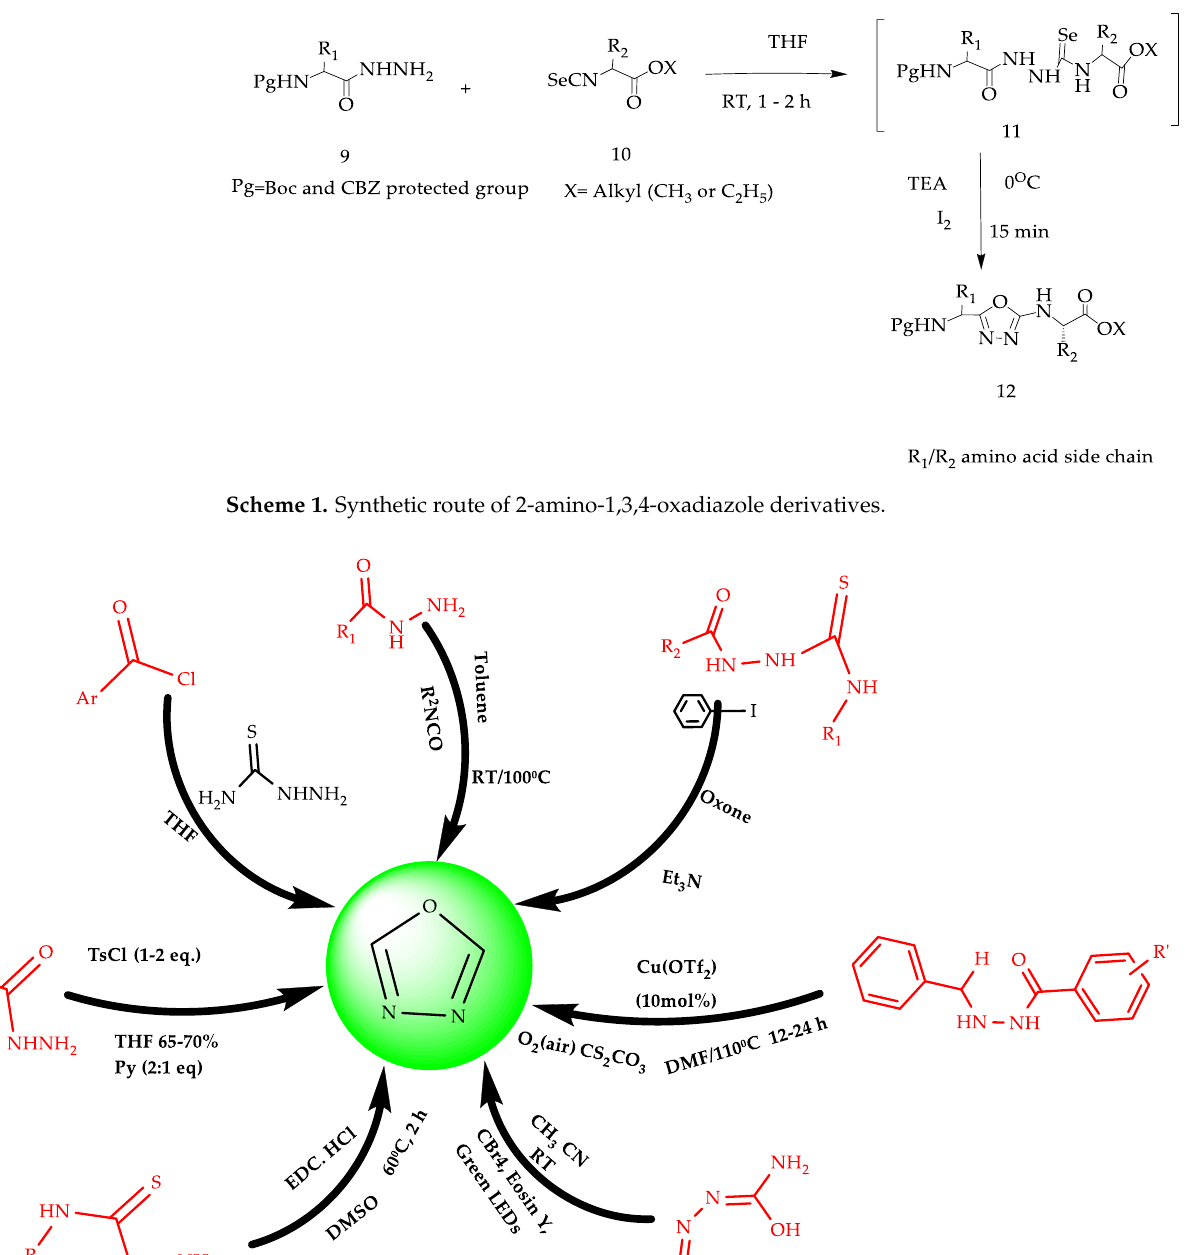
Figure 6. Various synthetic approaches for 1,3,4-oxadiazole derivatives .